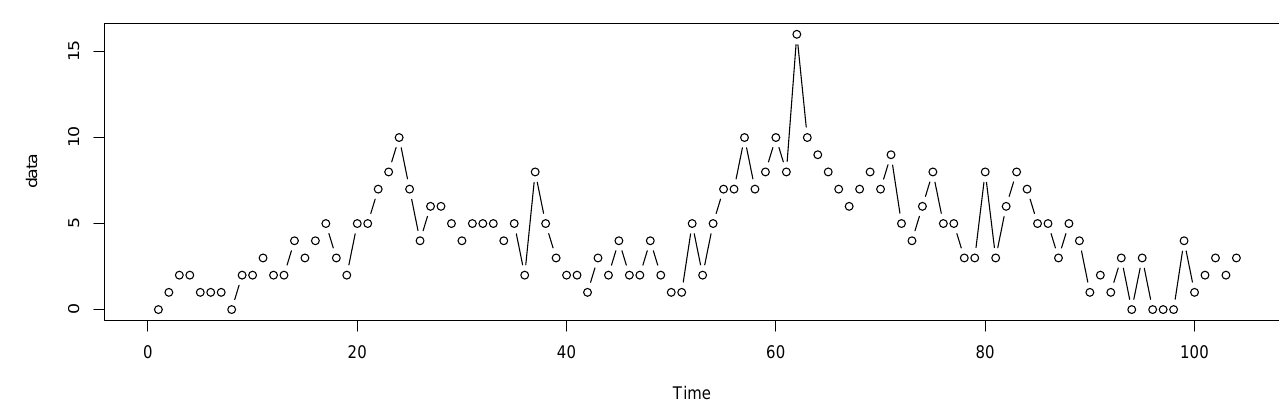
Figure 1. Path of the measles infection counts.